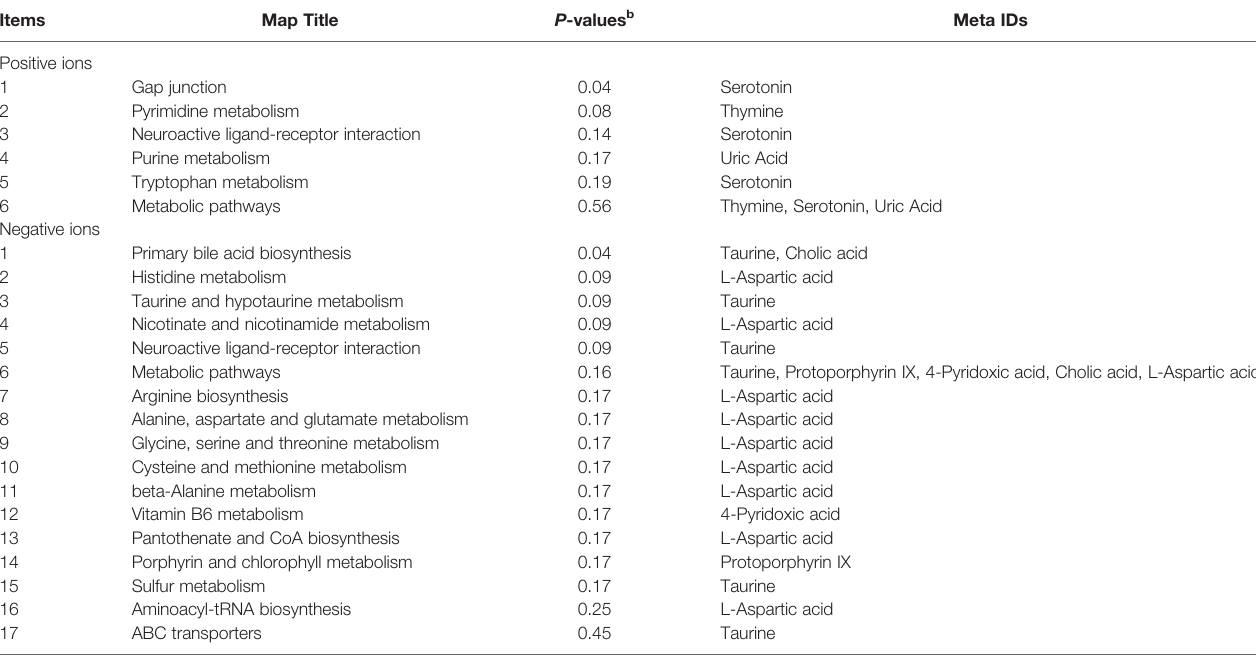
TABLE 5 | Annotation of KEGG a